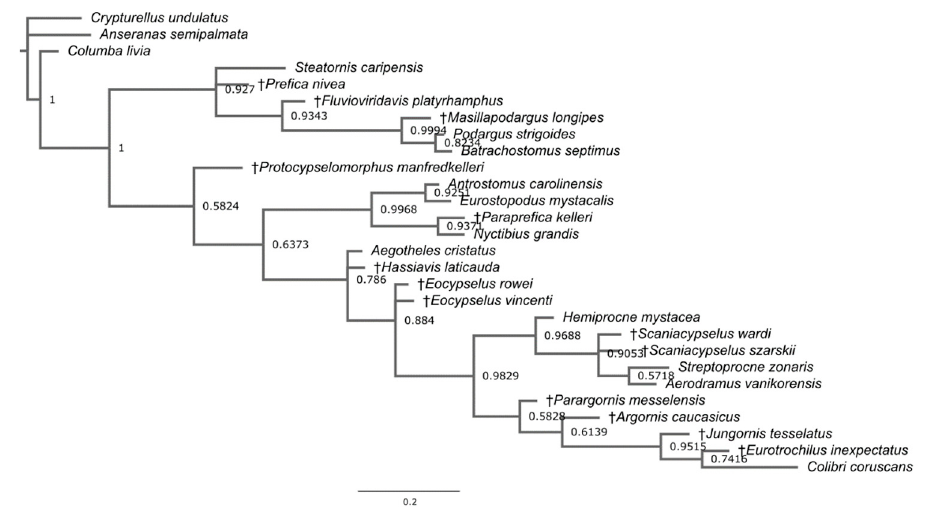
Figure 4. 50% majority-rule tree resulting from Analysis 3 (run with only morphological data, with Apodi constrained to be monophyletic). Numbers on nodes represent Bayesian posterior probabilities. Dagger (†) indicates extinct taxa.